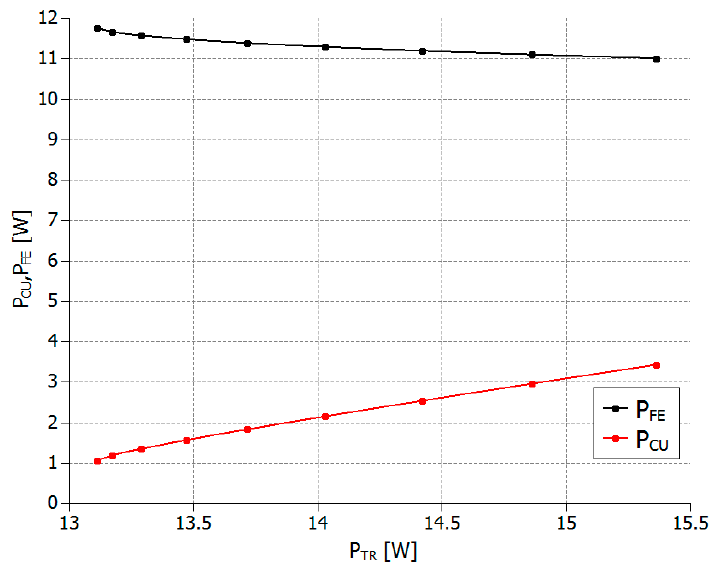
Figure 18. The estimated transformer power loss distribution in the DAB converter.